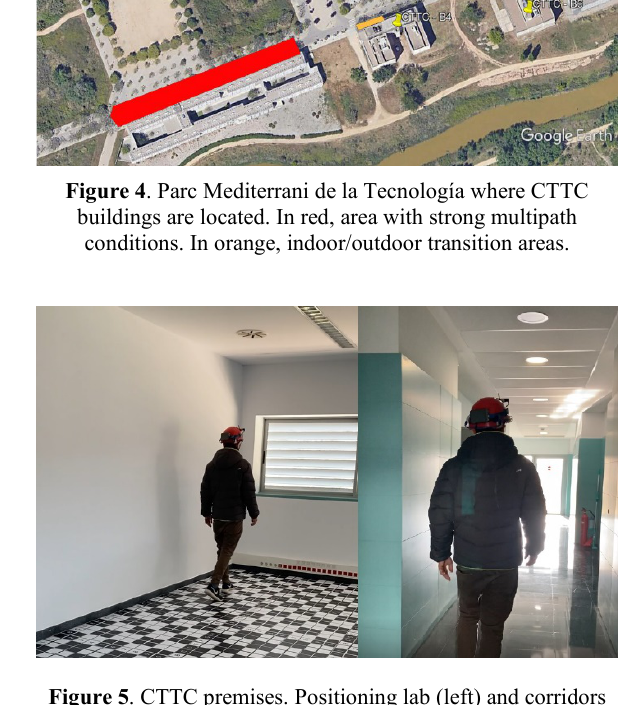
Figure 5 . CTTC premises. Positioning lab (left) and corridors (right).